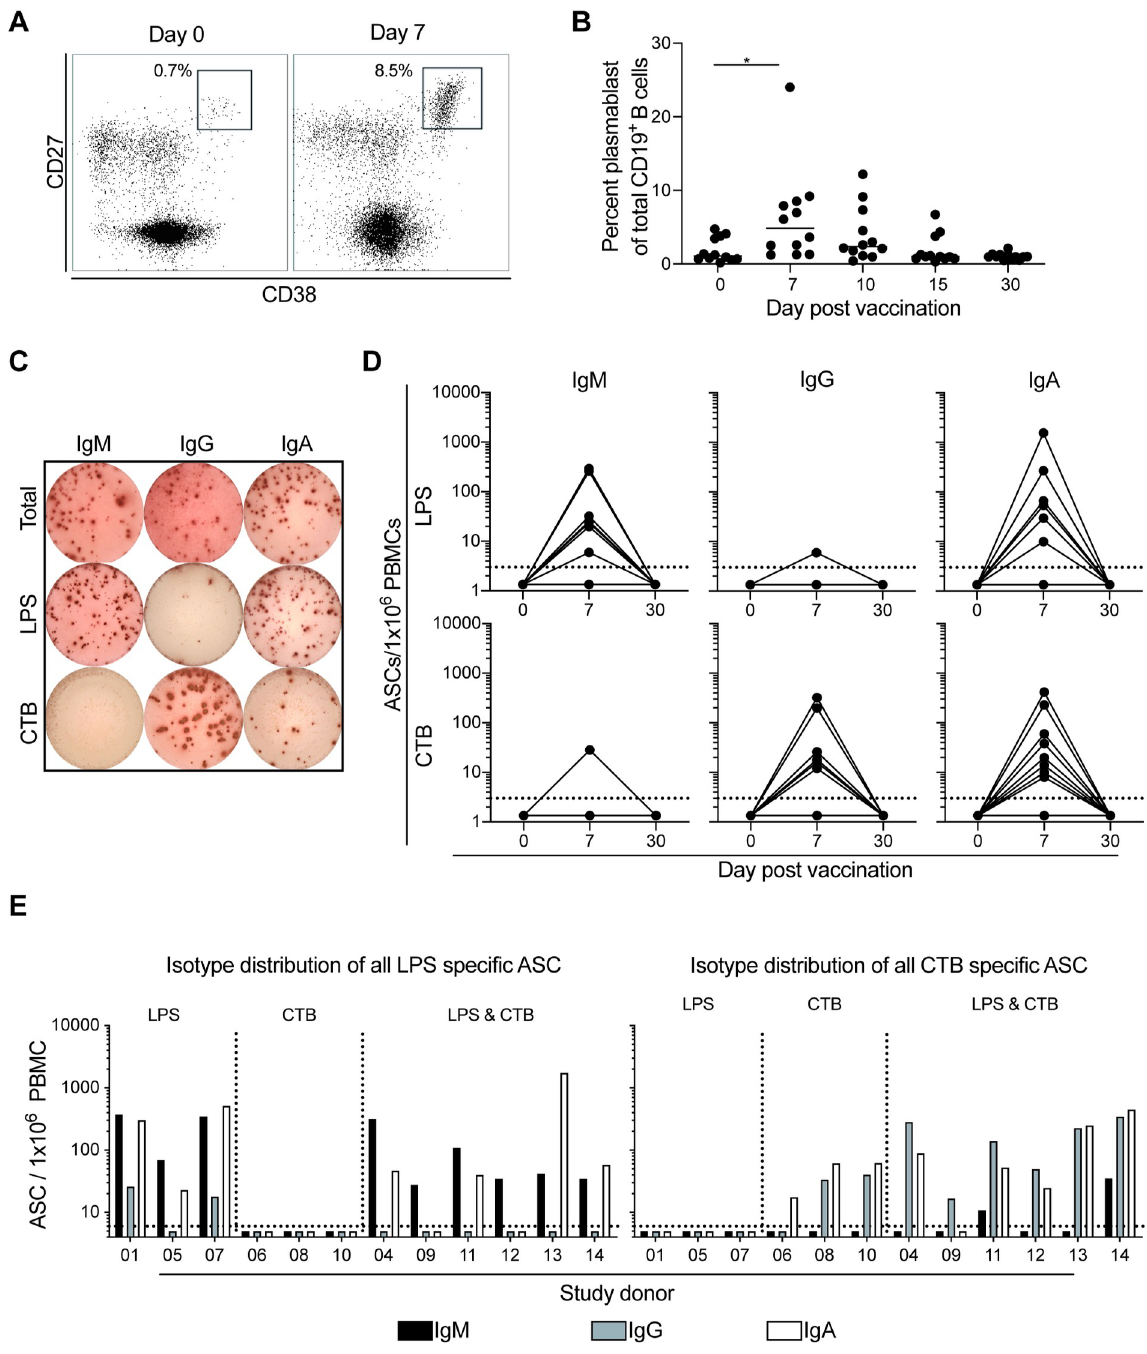
Fig 2. Antigen specific plasmablasts increase following vaccination. (A) Representative flow cytometry plot of the plasmablast population from one donor on day 0 and 7 post vacation. (B) Summary flow cytometry analysis of the plasmablast population following vaccination for each of the 12 participants on day 0, 7, 10, 15, and 30 post vaccination. (C) Representative ELISPOT of the total, LPS, and CTB specific IgM, IgG, and IgA ASC from one subject on day 7 post vaccination. (D) Summary ELISPOT analysis of lipopolysaccharide (LPS) and cholera toxin B subunit specific IgM, IgG, and IgA antibody secreting cells following vaccination from each of the 12 subjects on day 0, 7, and 30 post vaccination. Dotted line indicates limit of detection for the ELISPOT assay. (E) Isotype distribution of IgM (black) IgG (grey), and IgA (white) of all ASC for each of the 12 subjects. Dotted line indicates limit of detection for the ELISPOT assay. Statistical significance between bracketed samples was determined using a one-way ANOVA. Significance values are indicated by asterisks (P < 0.05 ( � ); P < 0.005 ( �� ); P < 0.0005 ( ��� ); P < 0.0001 ( ����